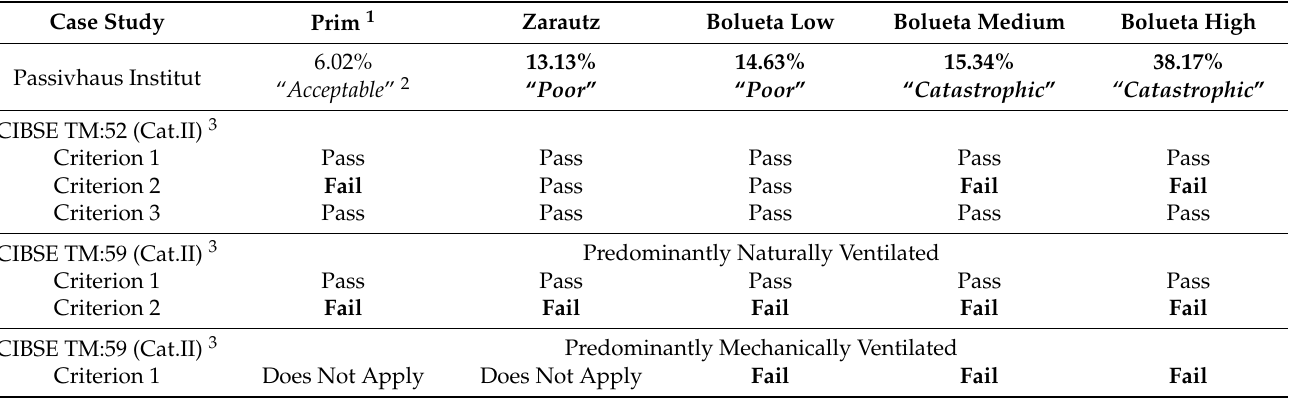
Table 13. Summary of overheating criteria